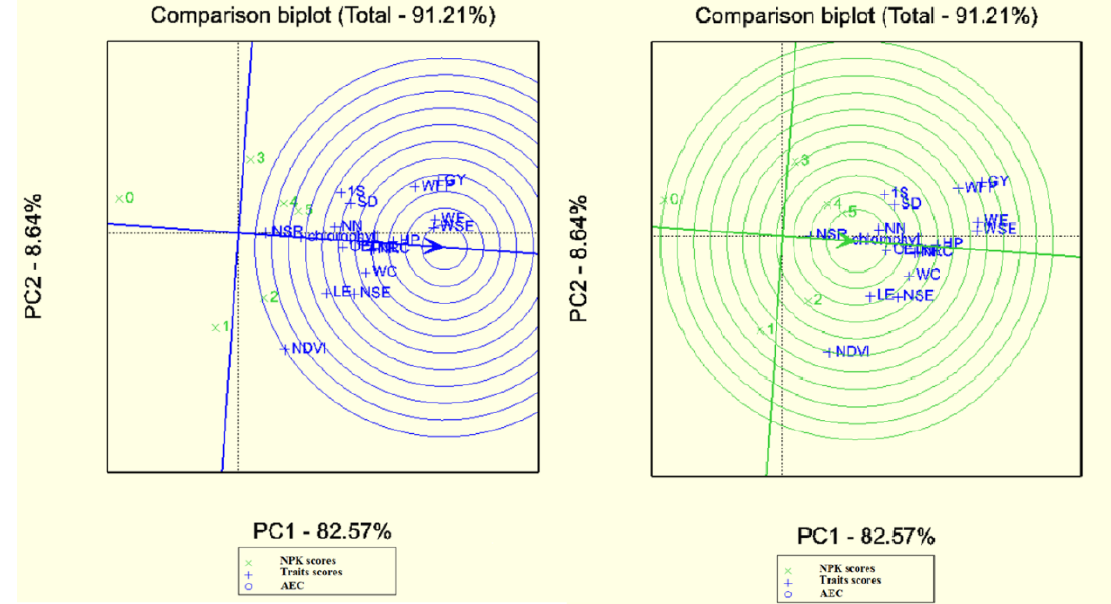
Figure 4. Determination of ideal traits and treatments with GGE biplot on FAO410. Chlorophyll (Chl), NDVI (NDV), plant height (HP), leaf number (LN), stem diameter (SD), diameter of ear (OED), node number (NN), weight of ear (WE), weight of cob corn (WC), weight of ear (WE), weight of cob (WC), number of seeds in row (NSR), number of seeds per column (NSC), length of ear (LE), weight of all seeds in ear (WSE), number of seeds per ear (NSE), weight of fresh plant (WFP), weight of 1000 seeds (1S), grain yield (GY). 0until5 treatments NPK.